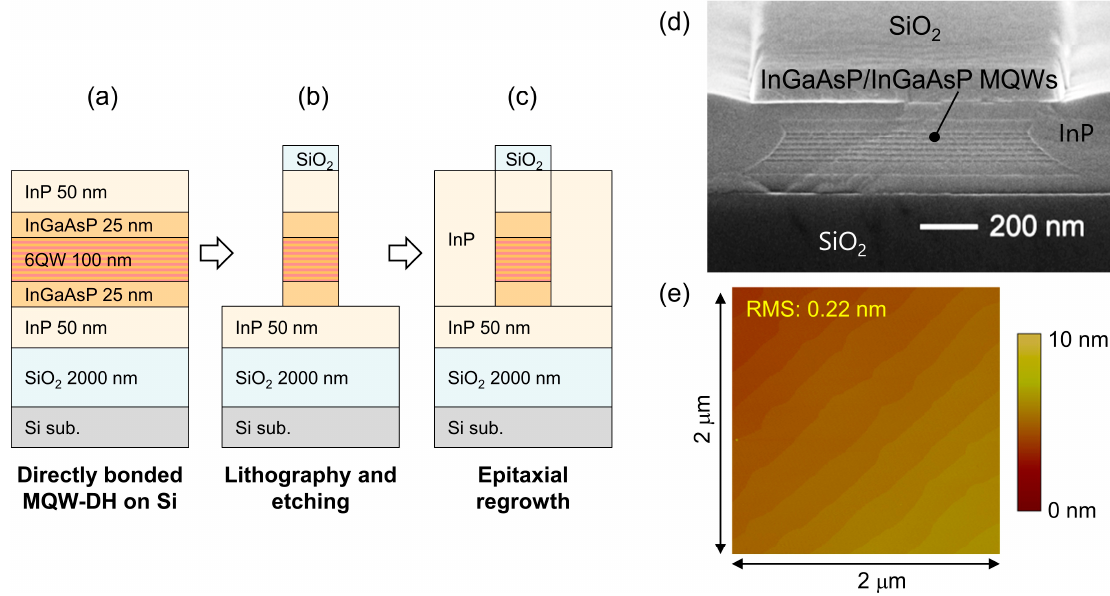
Figure 5. ( a – c ) Process flow of fabricating buried-heterostructure (BH) using MQW-DH on SiO 2 /Si substrate; ( d ) cross- sectional SEM image of BH on SiO 2 /Si substrate; ( e ) atomic force microscope (AFM) image of surface of InP membrane on SiO 2 /Si substrate after epitaxial growth.